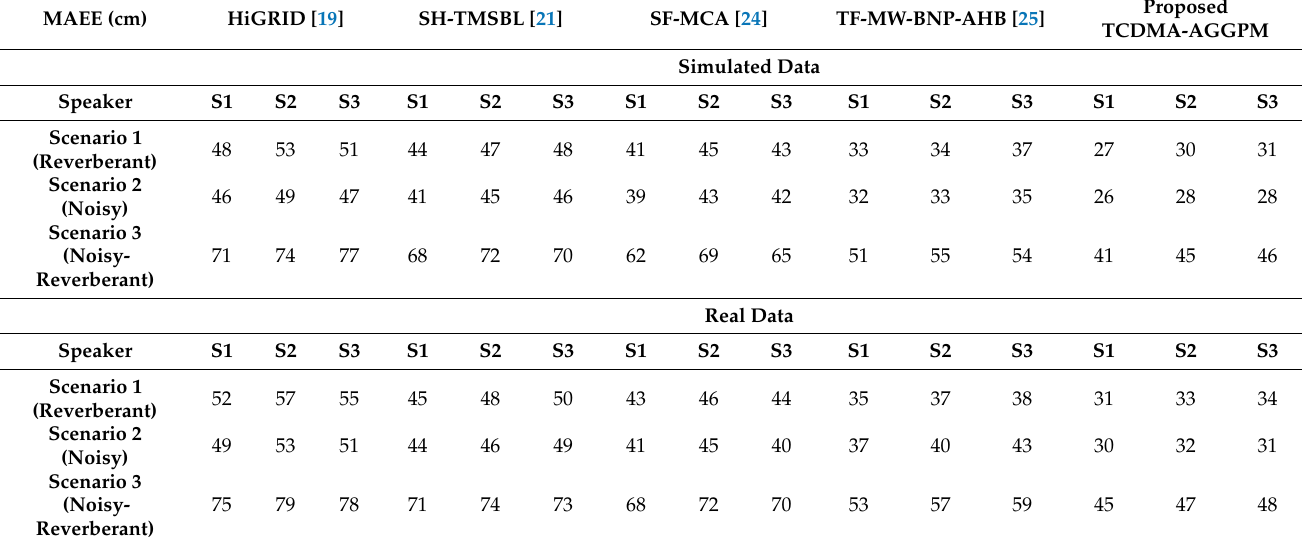
Table 3. The MAEE results (in cm) for the proposed TCDMA-AGGPM algorithm in comparison with HiGRID, SH-TMSBL, SF-MCA, and TF-MW-BNP-AHB methods on real and simulated data, for 3 simultaneous speakers and for reverberant (scenario 1), noisy (scenario 2), and noisy-reverberant (scenario 3)